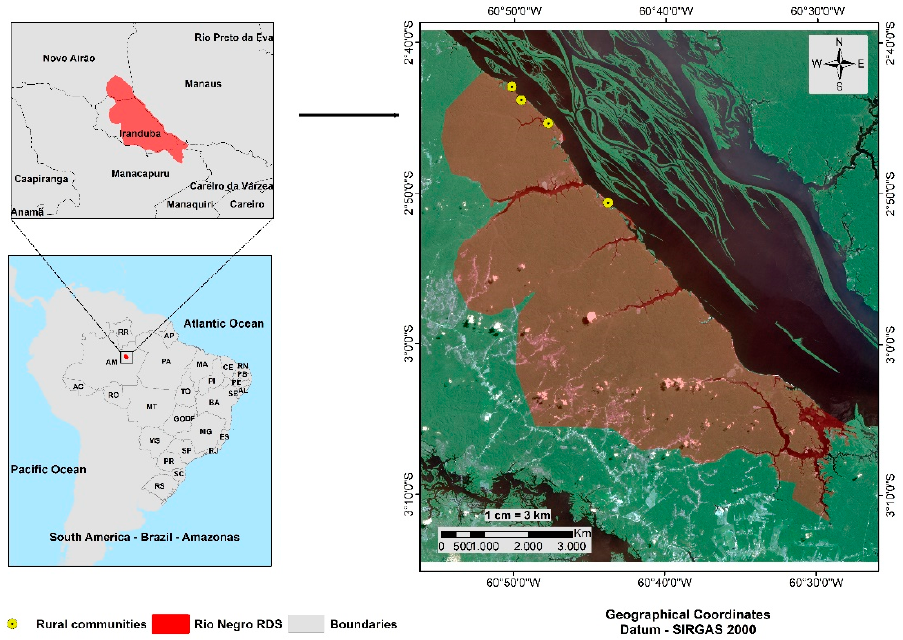
Figure 1. Location of the Rio Negro RDS, Amazonas. Created by authors.